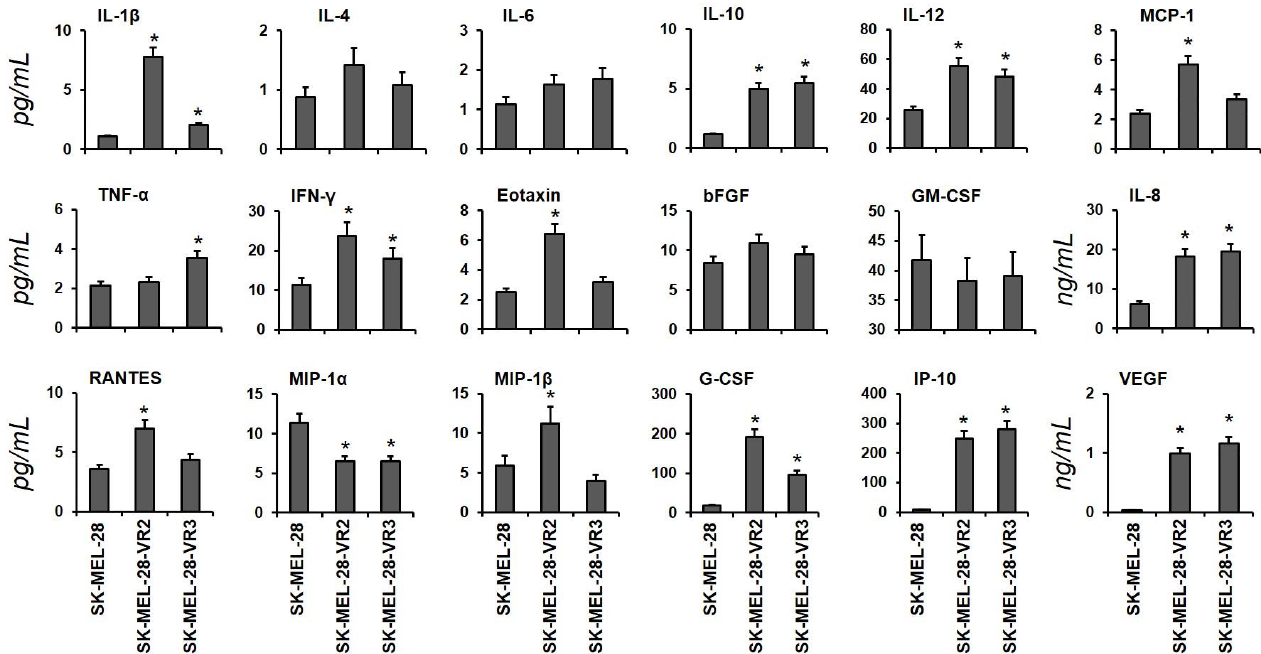
Figure 1. Analysis of cytokines and chemokines secreted by SK-MEL-28 (sensitive, parental) and vemurafenib-resistant (VR2 and VR3) melanoma cells. Concentrations of the indicated analytes in conditioned media (CM) were quantified by multiplex immunoassay. Results are shown as mean ± SD of triplicate samples (statistical significance versus sensitive cell lines: * p < 0.01).